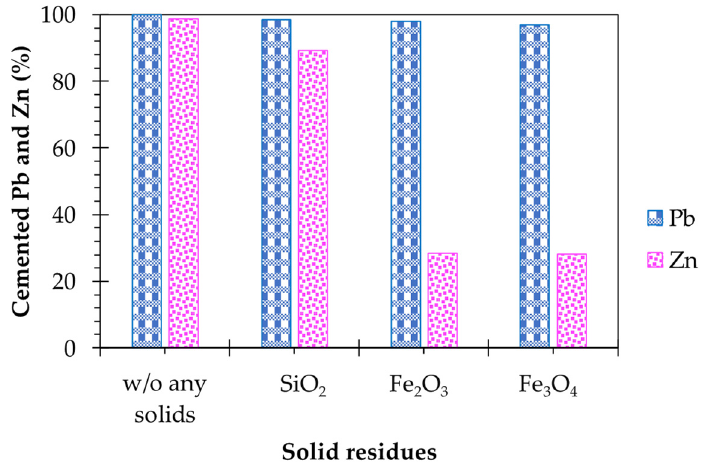
Figure 8. Effects of SiO 2 , Fe 2 O 3 , and Fe 3 O 4 on cementation of Pb and Zn when 2.5 of a given mineral was mixed in 3 M NaOH solution containing 8 mM of Pb 2+ and Zn 2+ for 30 min (for interpretation of the references to color in this figure legend, the reader is referred to the web version of this article).